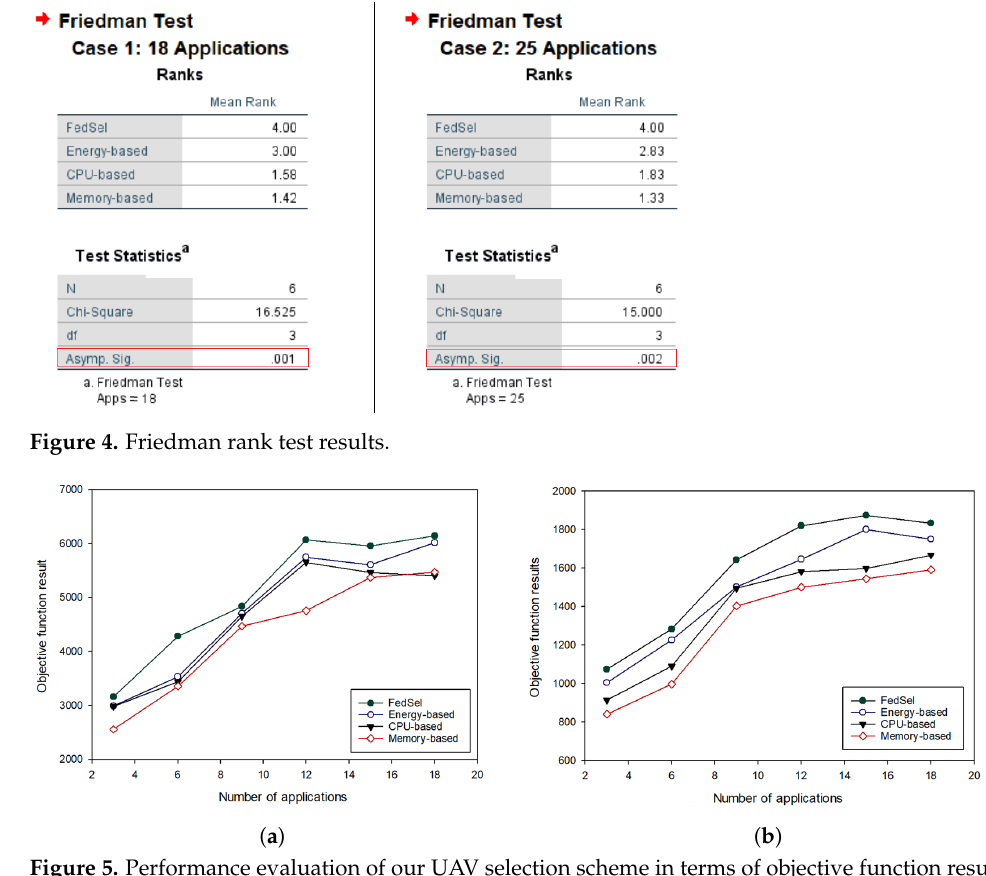
Figure 5. Performance evaluation of our UAV selection scheme in terms of objective function results while varying the number of applications [3, 6, 9, 12, 15, 18]. ( a ) the number of UAVs deployed is 30, ( b ) the number of UAVs deployed is 105.